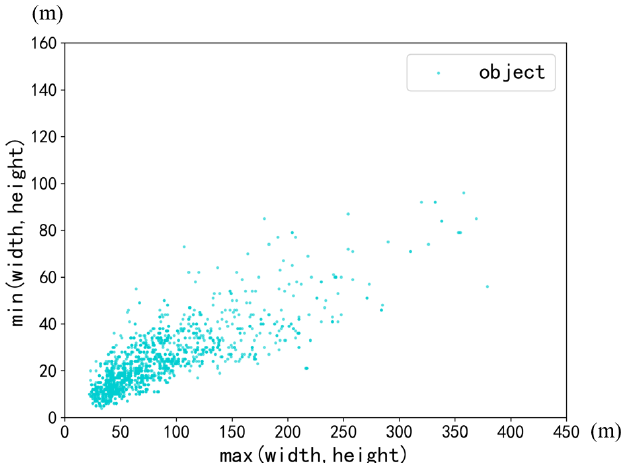
Figure 9. The scatter of the aspect ratio distribution and the length of ships in the dataset.